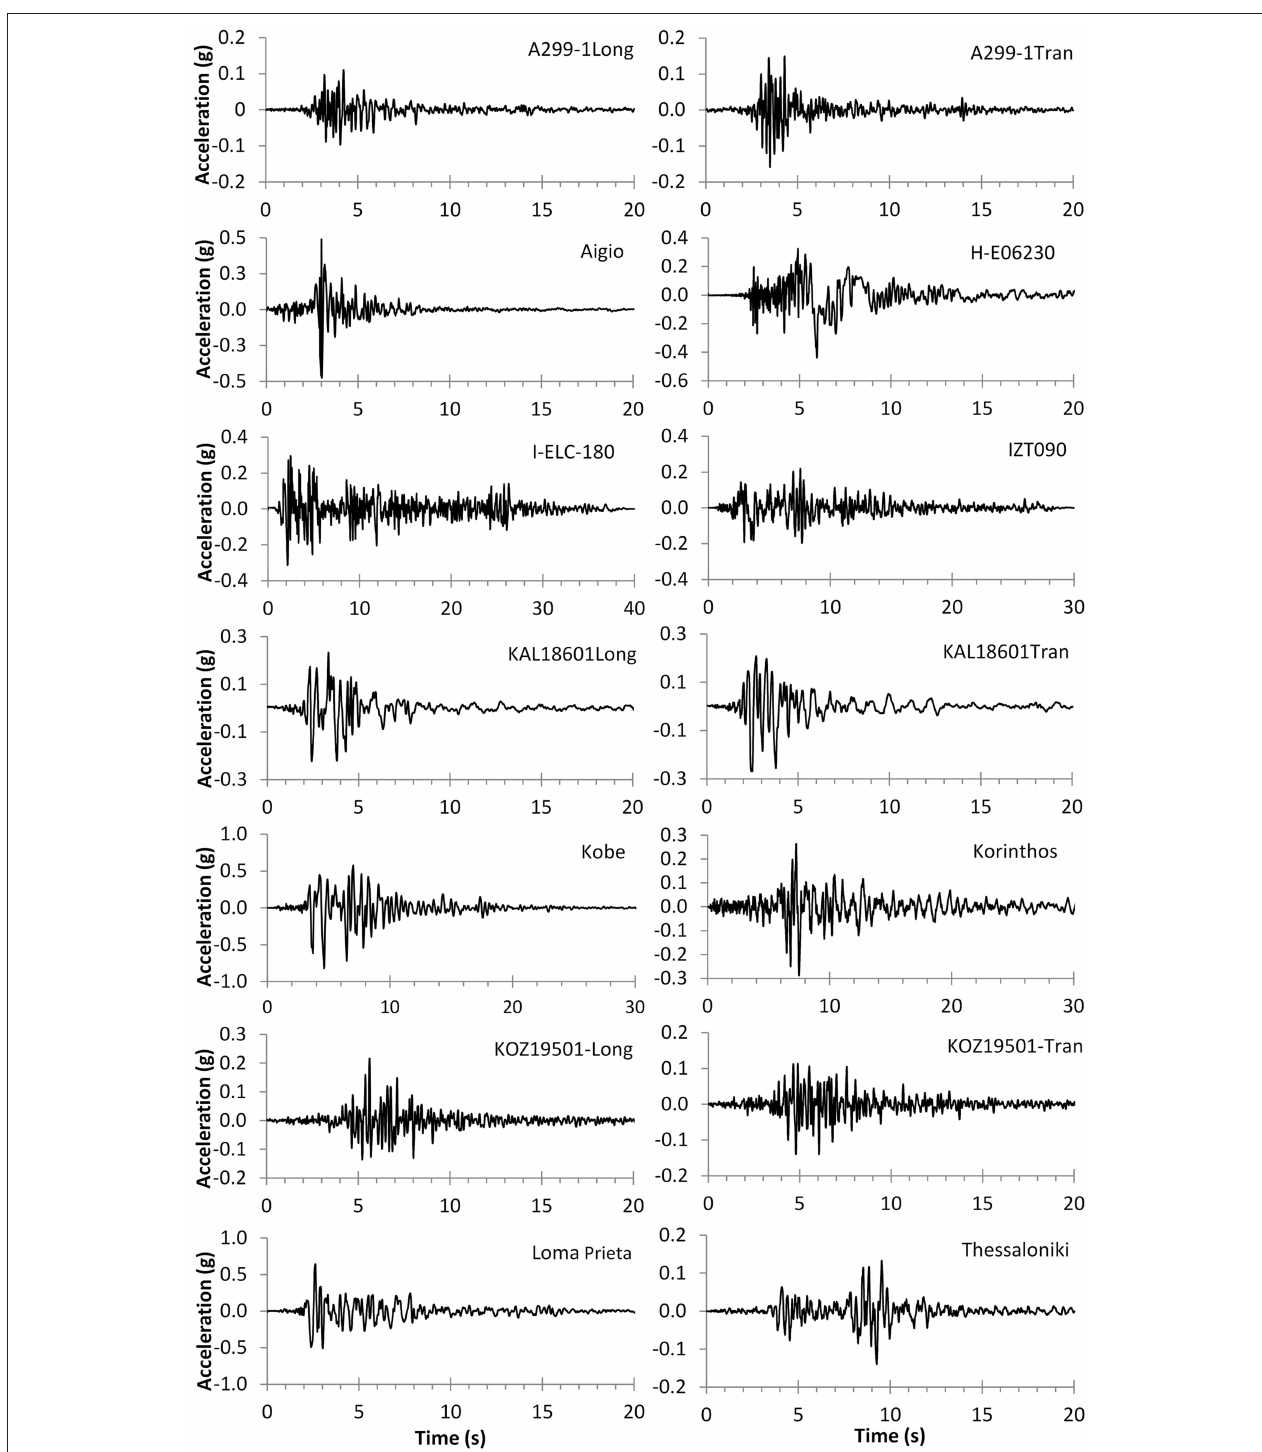
FIGURE 5 | Earthquake record time histories used in IDA analysis. failure are identified. The upper bound of the intensity of the base excitation is reached when the predefined limiting roof displacement is exceeded. Next, additional time history